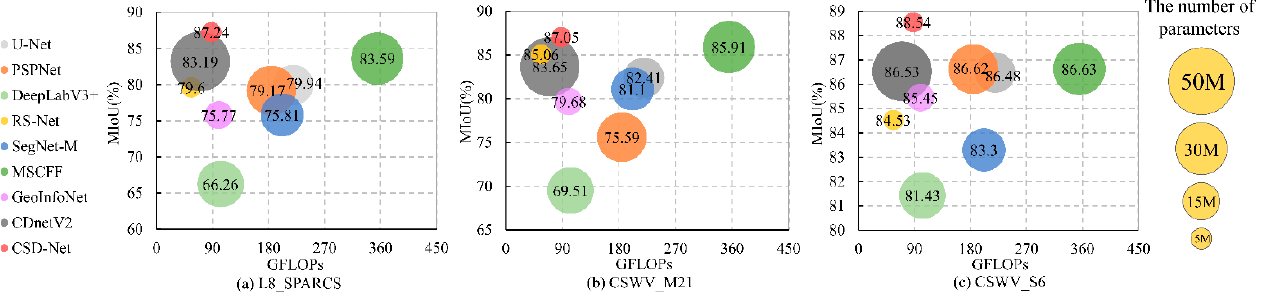
Figure 16. The accuracy and complexity bubble charts of different methods. ( a – c ) The comparisons of the various methods based on the L8_SPARCS, CSWV_M21, and CSWV_S6, respectively. The various colors of circles symbolize different networks. The vertical axis is the value of MIoU, while the value of FLOPs is represented on the horizontal axis. The center of the circle corresponds to its MIoU and FLOPs, and the area of the circle reflects its parameter quantity.